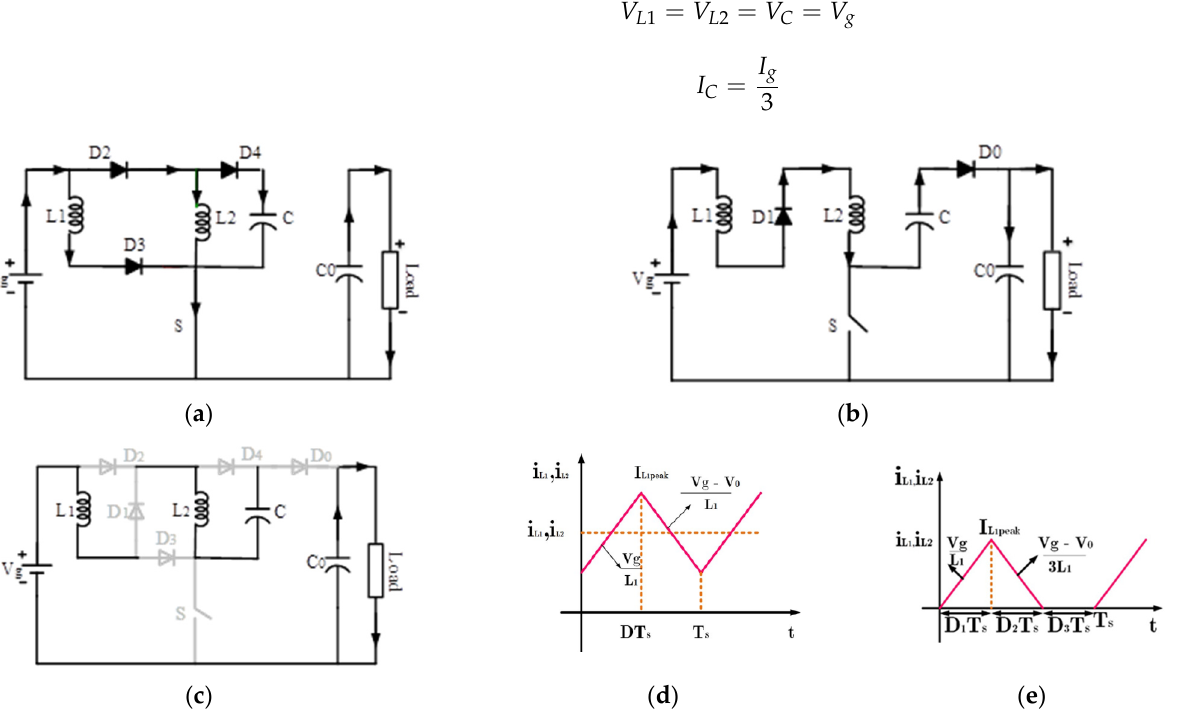
Figure 3. Operating modes ( a ) Mode I, ( b ) Mode II, ( c ) DCM, ( d , e ) Inductor waveform at CCM and DCM.